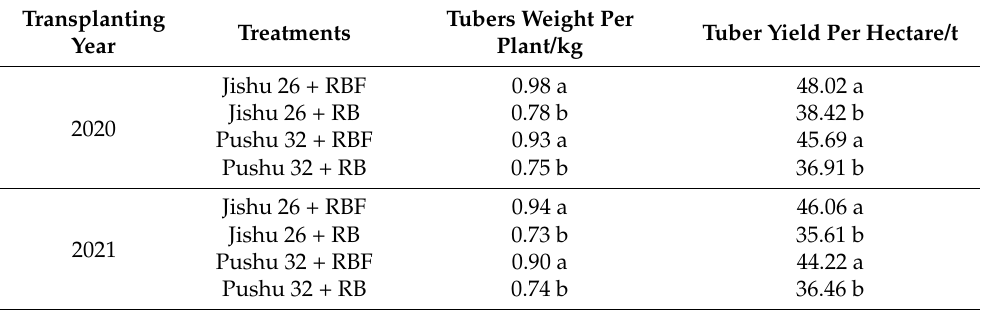
Table 3. Tuber yield with the 2CGFS-2 compound sweet potato transplanter for four treatments in 2020 and 2021. Note: Means of the same year within a column followed by the same letters are not significantly different at p = 0.05.